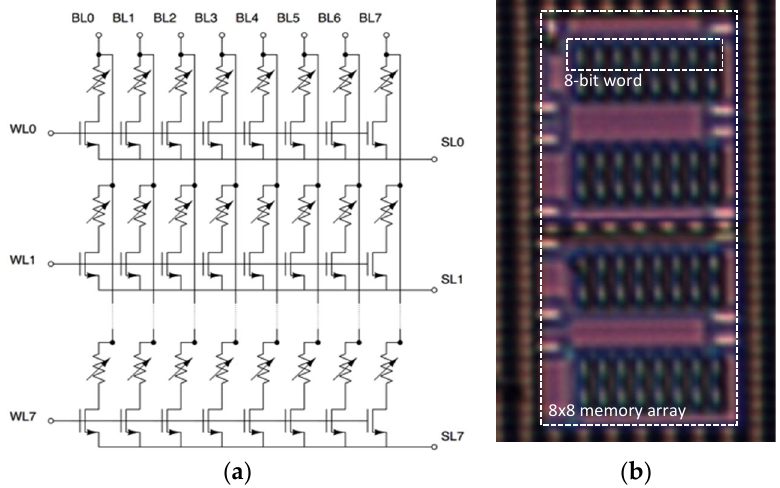
Figure 3. ( a ) 8 × 8 OxRAM memory array and ( b ) corresponding micrograph of the memory array test chip fabricated in a 130 nm CMOS technology.